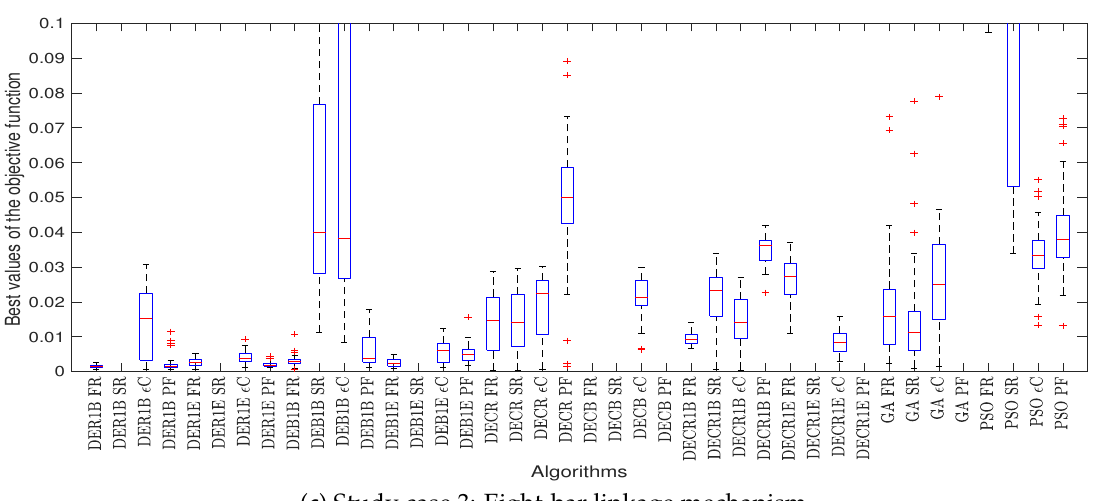
( b ) Study case 2: Cam-linkage mechanism.